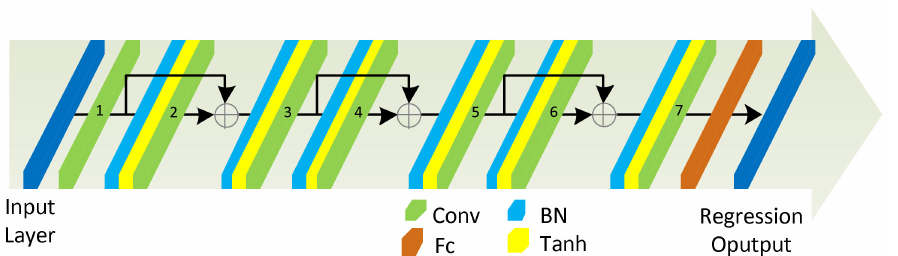
Figure 3. The framework of DnCNN, Conv is the convolutional layer, BN is the batch normalization layer, FC is the fully connected layer, Tanh is the hyperbolic tangent activation function of the nonlinearity